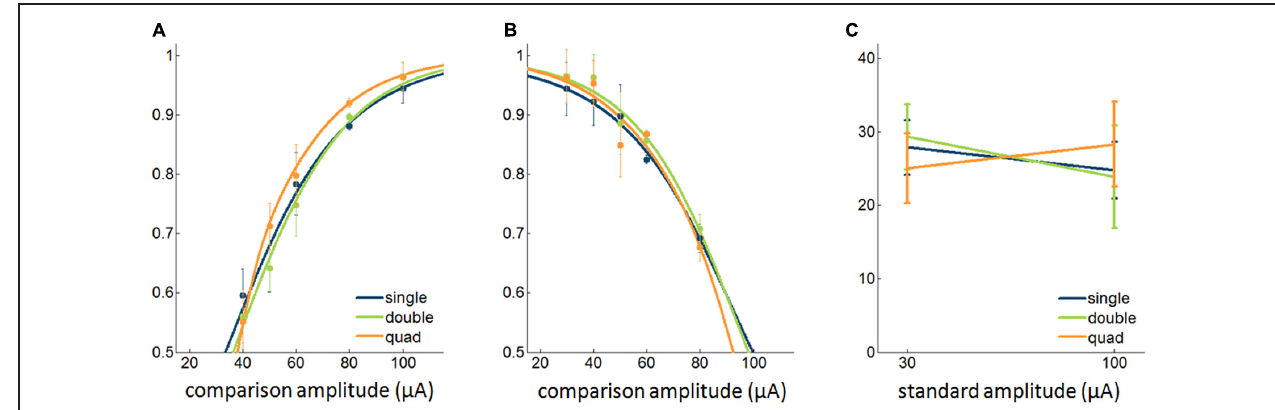
FIGURE 5 | Effect of multi-electrode stimulation on the discriminability of ICMS. (A,B) Psychometric functions with a 30- μ A and 100- μ A standard, respectively (9,280 trials from 12 sets of electrodes). (C) JNDs with different standard amplitudes. Error bars denote the SEM.